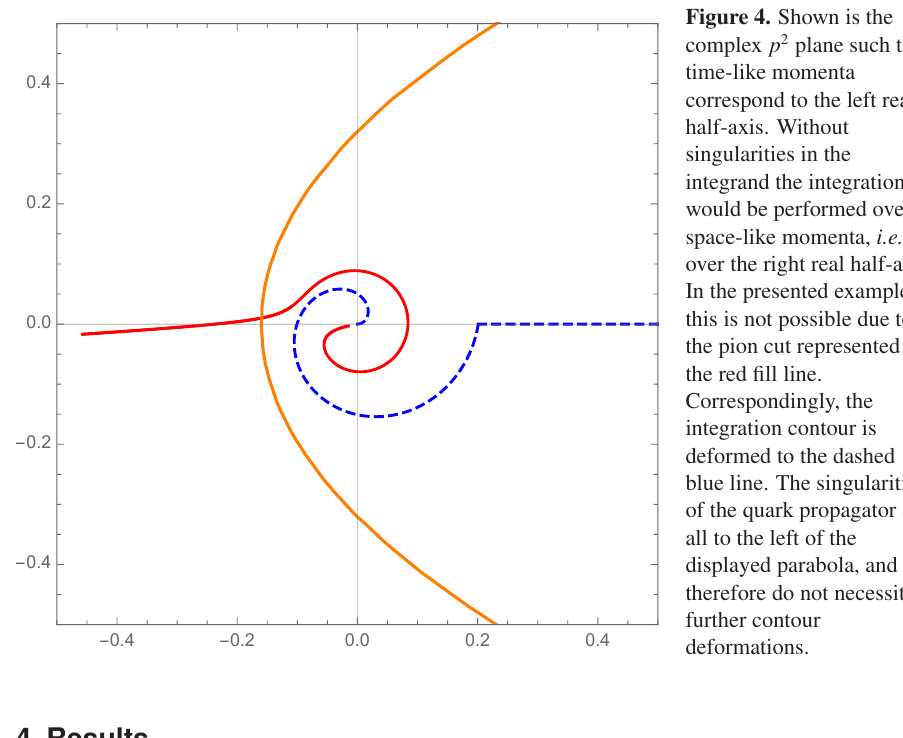
Figure 2. Absolute value of